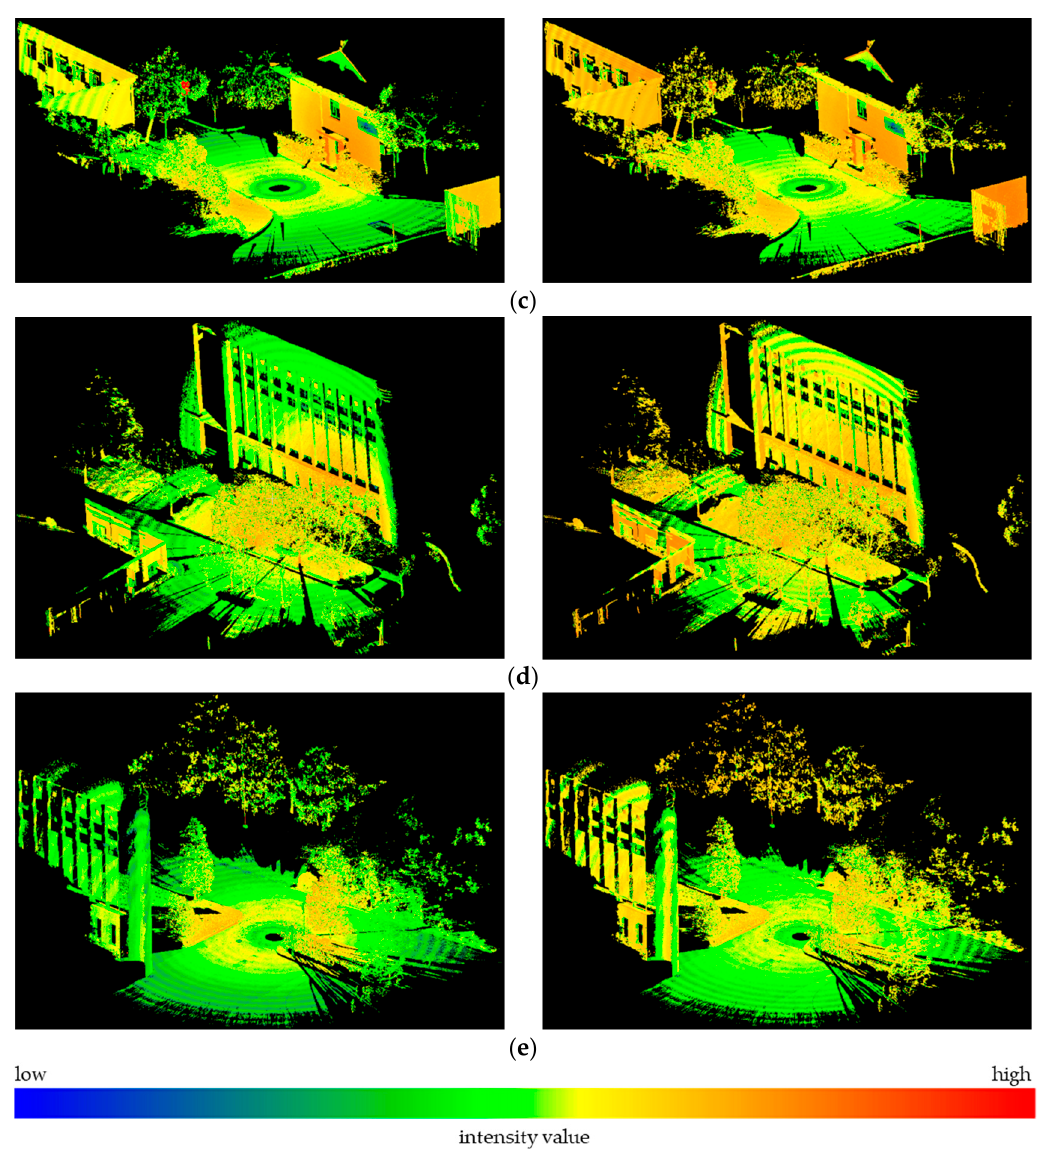
Figure 3. Original intensity (left) and corrected intensity (right) for: ( a ) training set, ( b ) testing case 1, ( c ) testing case 2, ( d ) testing case 3, and ( e ) testing case 4.